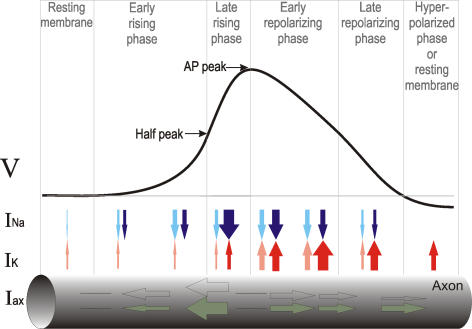
Diagrammatic Representation of a Traveling AP on the AxonStacked over each other, the membrane potential wave form of the AP (V) along the axon, axial currents flowing along the axon (Iaxial, green), Na (INa, blue), and K currents (IK, red), and the representation of the axon itself. Axial, Na, and K currents are denoted by green, red, and blue arrows scaled to represent the relative size of the current in the various AP phases. Hollow and light-shaded arrows denote the size of the current fluctuations relative to the average currents. The AP wave form is subdivided into six phases: resting membrane, early rising phase, late rising phase, early repolarizing phase, late repolarizing phase, and an optional hyperpolarized phase (as some types of axons do not hyperpolarize). See text for details.